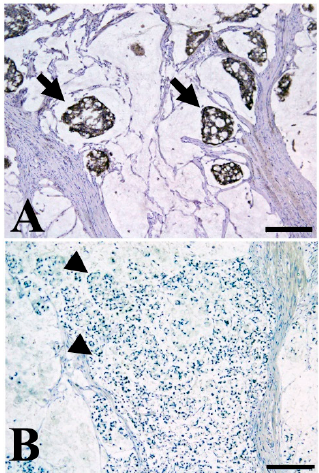
Figure 2. Representative immunohistochemical staining of mucinous colon cancer with